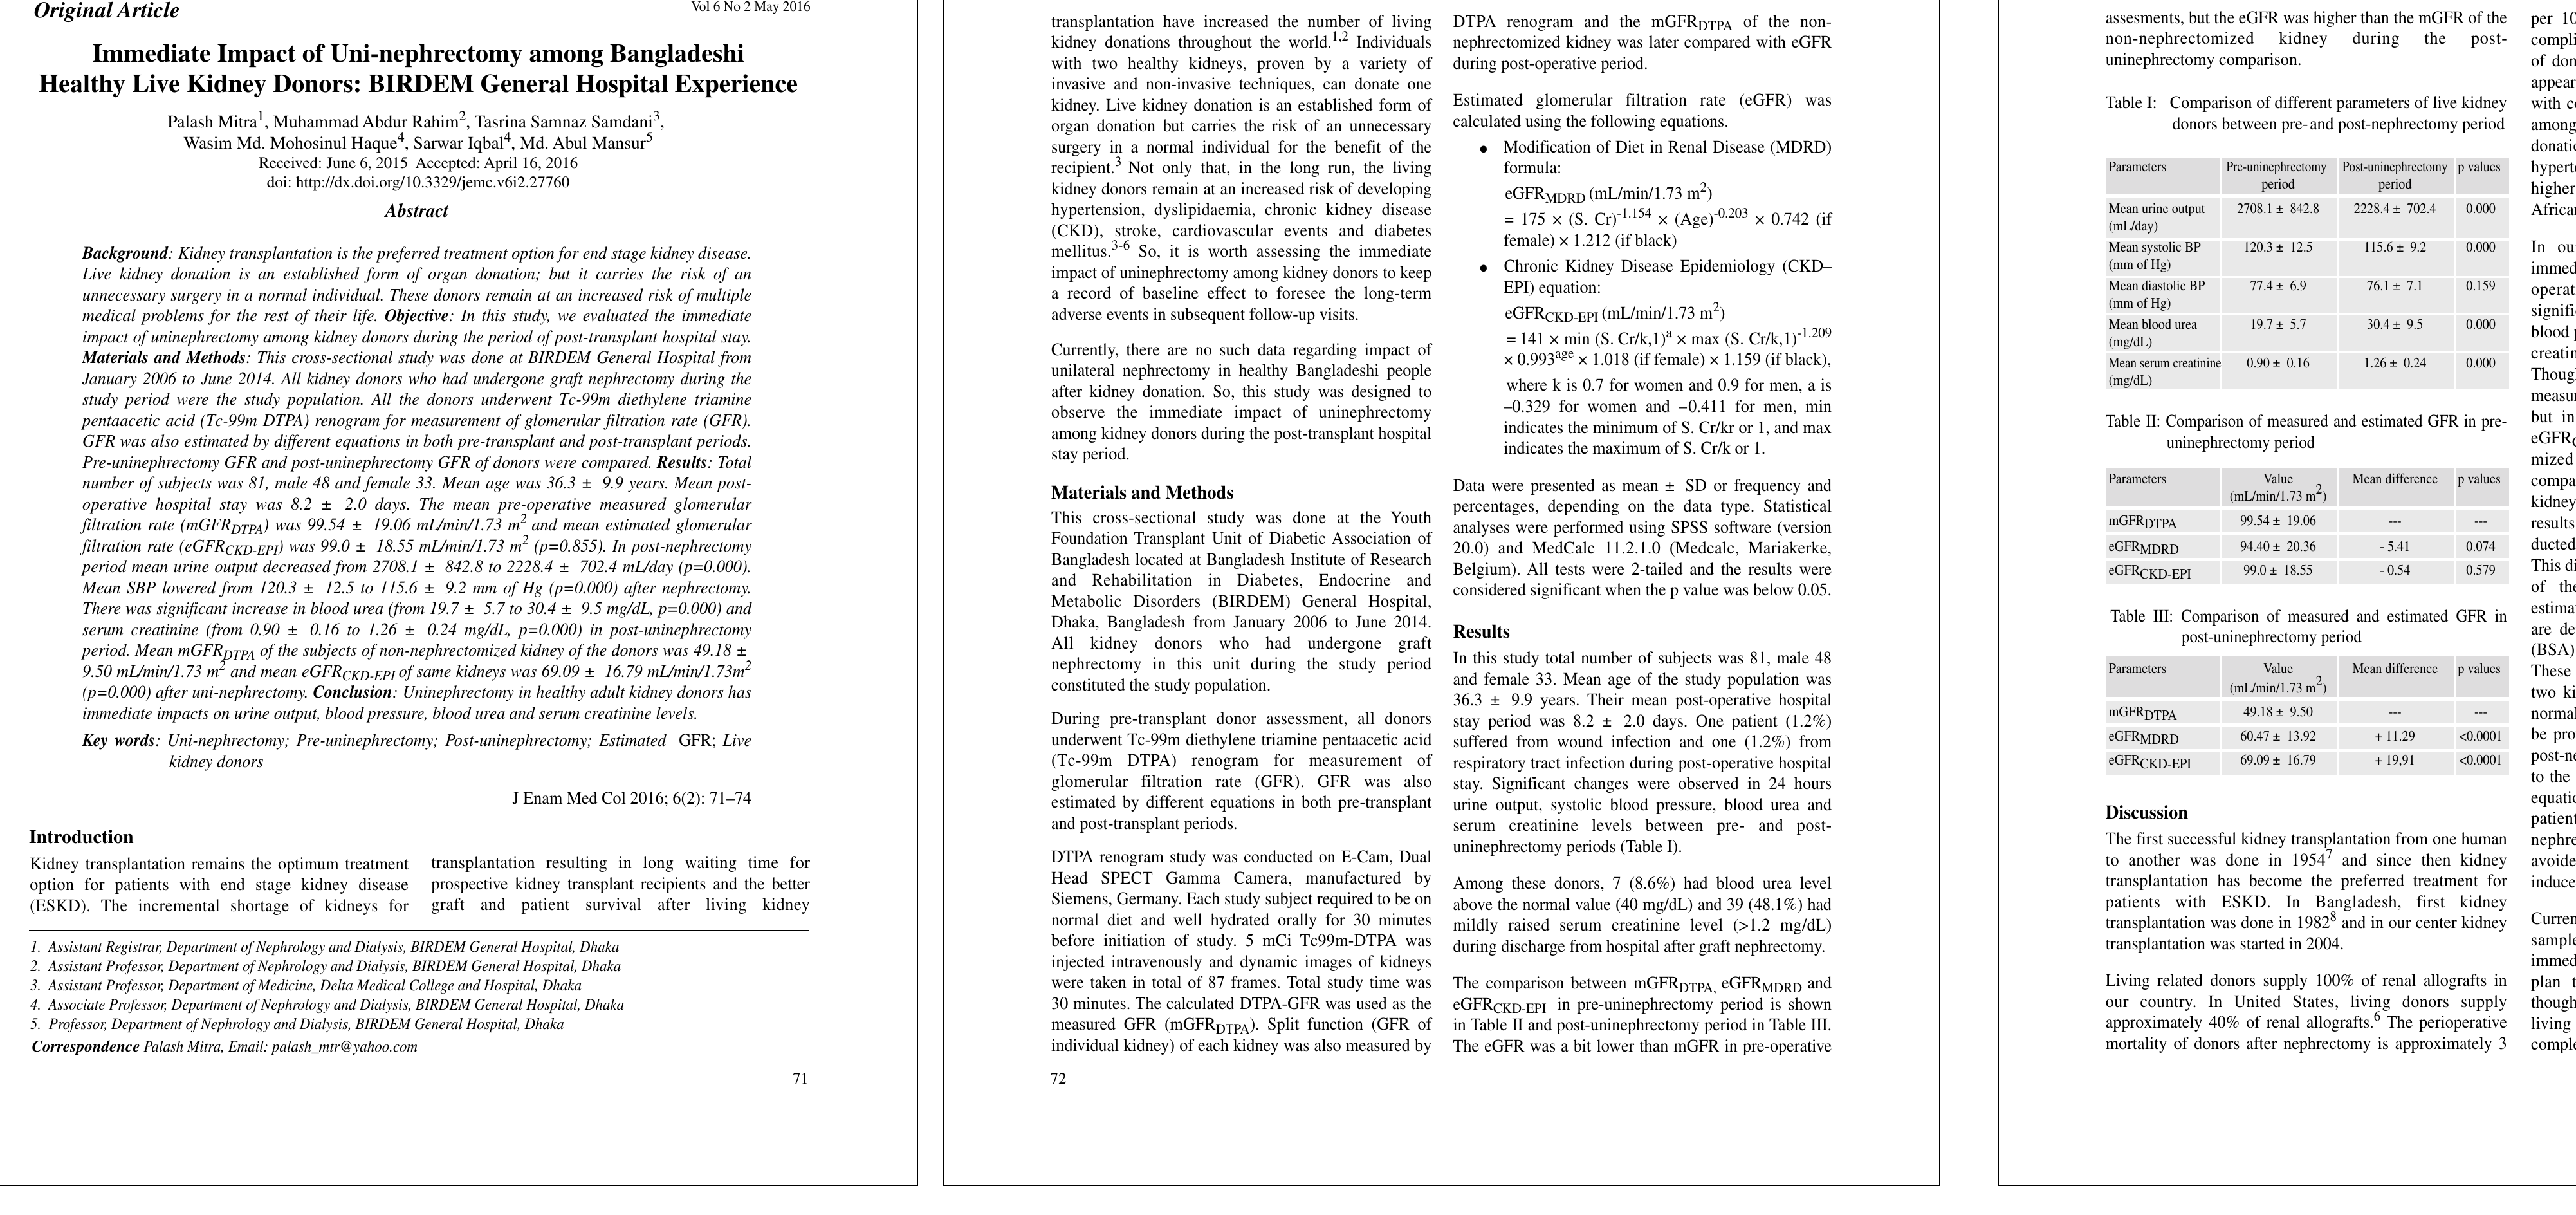
Table I: Comparison of different parameters of live kidney